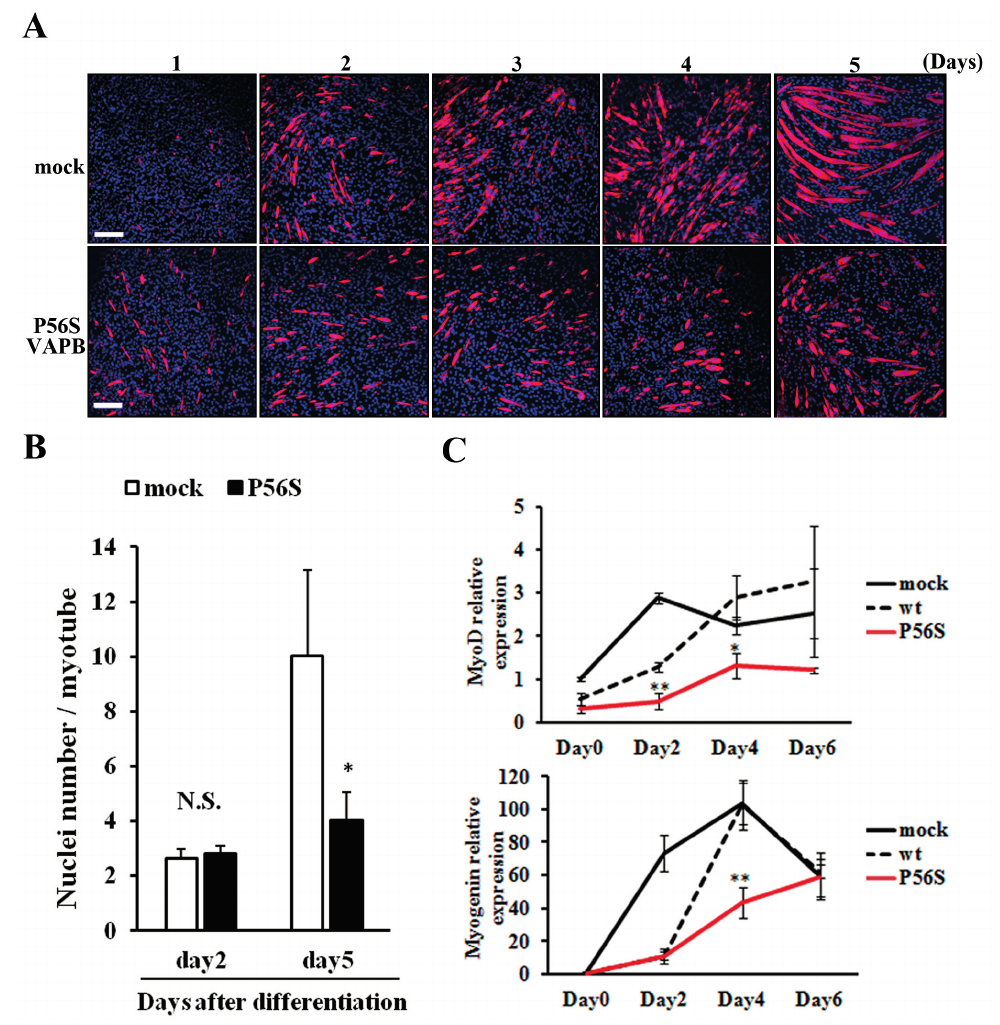
Figure 3. P56S mutation suppressed fusion of C2C12 cells for late-stage differentiation. ( A ) P56S mutation suppressed fusion of C2C12 cells for late-stage differentiation. GFP (mock) or P56S-VAPB stable expressing cell lines were induced to differentiate